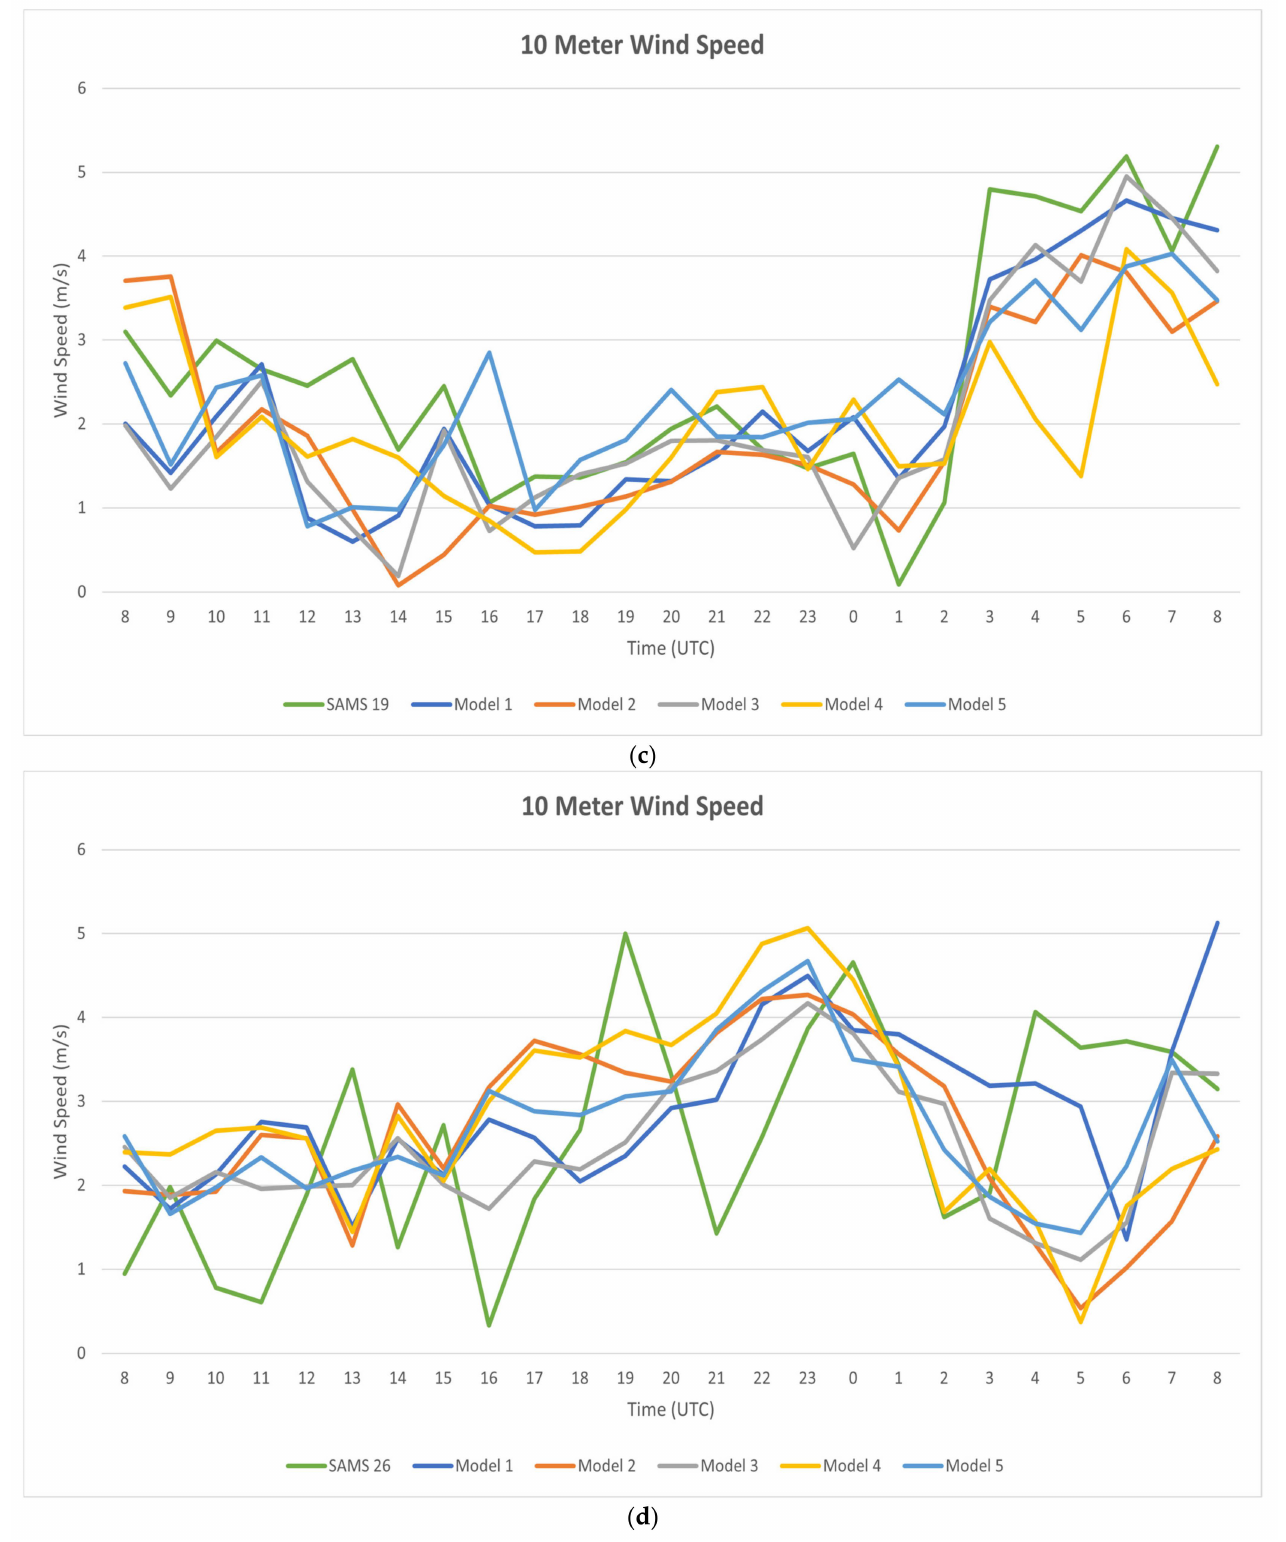
Figure 9. ( a ) Observed 10 m AGL surface wind speed (m/s) compared with model-simulated 10 m AGL surface wind speed (m/s) for the different experiments across IOP6 at SAMS playa ( a ) site 9, ( b ) site 18, ( c ) site 19, ( d ) site 26 as shown in Figure